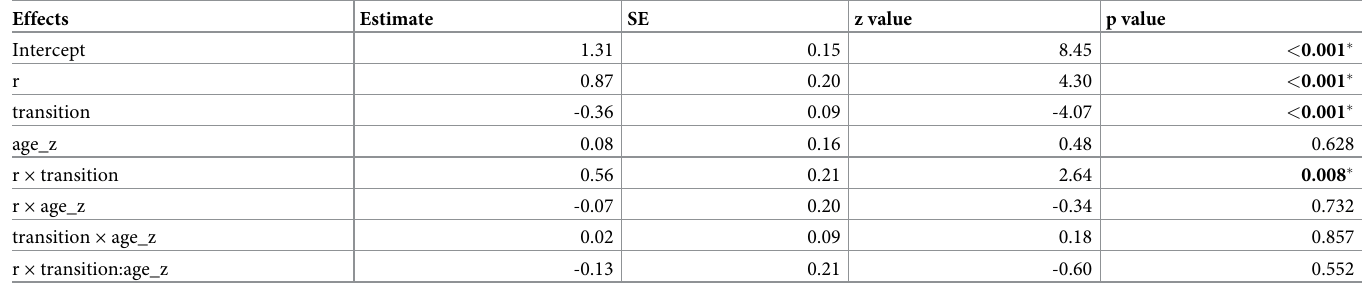
Table 4. Random effects logistic regression for probability of staying (collected data).